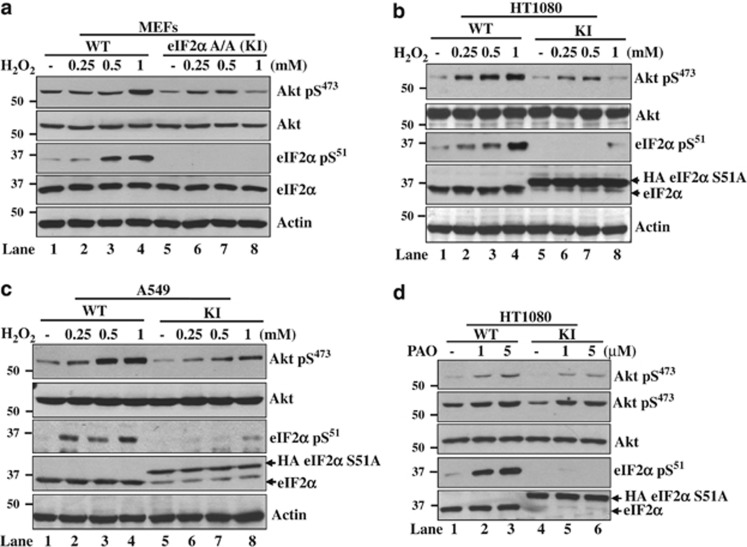
eIF2αP promotes Akt activation in response to oxidative stress. eIF2αP-proficient as well as -deficient immortalized MEFs (a), HT1080 cells (b and d) or A549 cells (c) were exposed to the indicated concentrations of either H2O2 (a–c) for 2 h or PAO for 15 min (d). Protein extracts (50 μg) were immunoblotted for the indicated proteins. The decreased migration of HA-eIF2αS51A in KI cells compared with endogenous eIF2α is indicated (b and c, lanes 5–8; d, lanes 4–6)